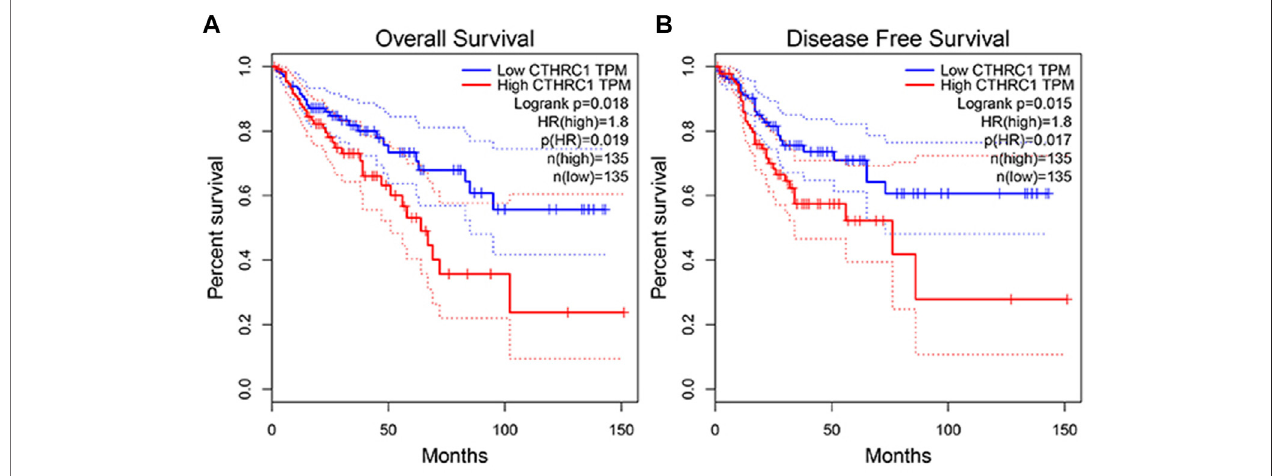
FIGURE4| CorrelationanalysisbetweenCTHRC1expressionandprognosticsurvivalinpatientswithcolonadenocarcinoma(COAD)usingGEPIA. (A) Correlation analysis between CTHRC1 expression and overall survival in patients with COAD; (B) Correlation analysis between CTHRC1 expression and disease free survival in patients with